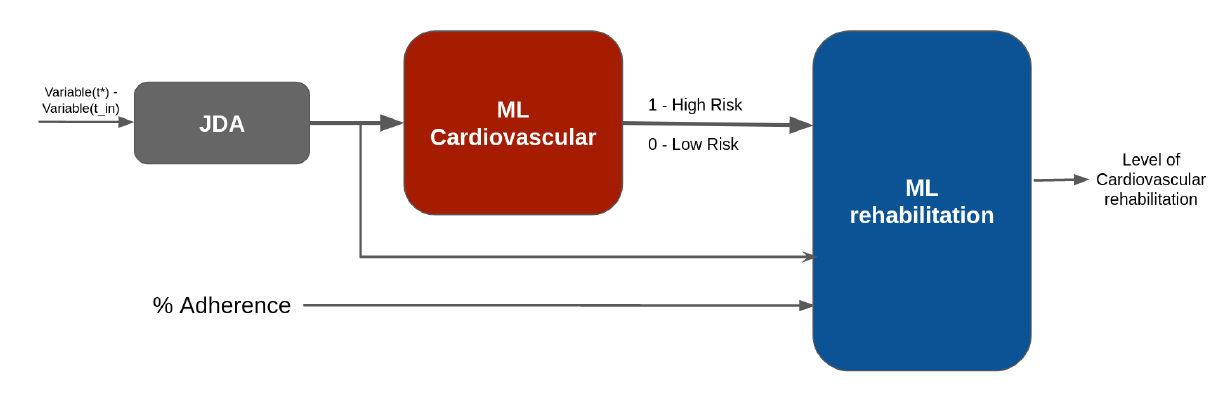
Figure 4. Stacked machine learning with transfer feature